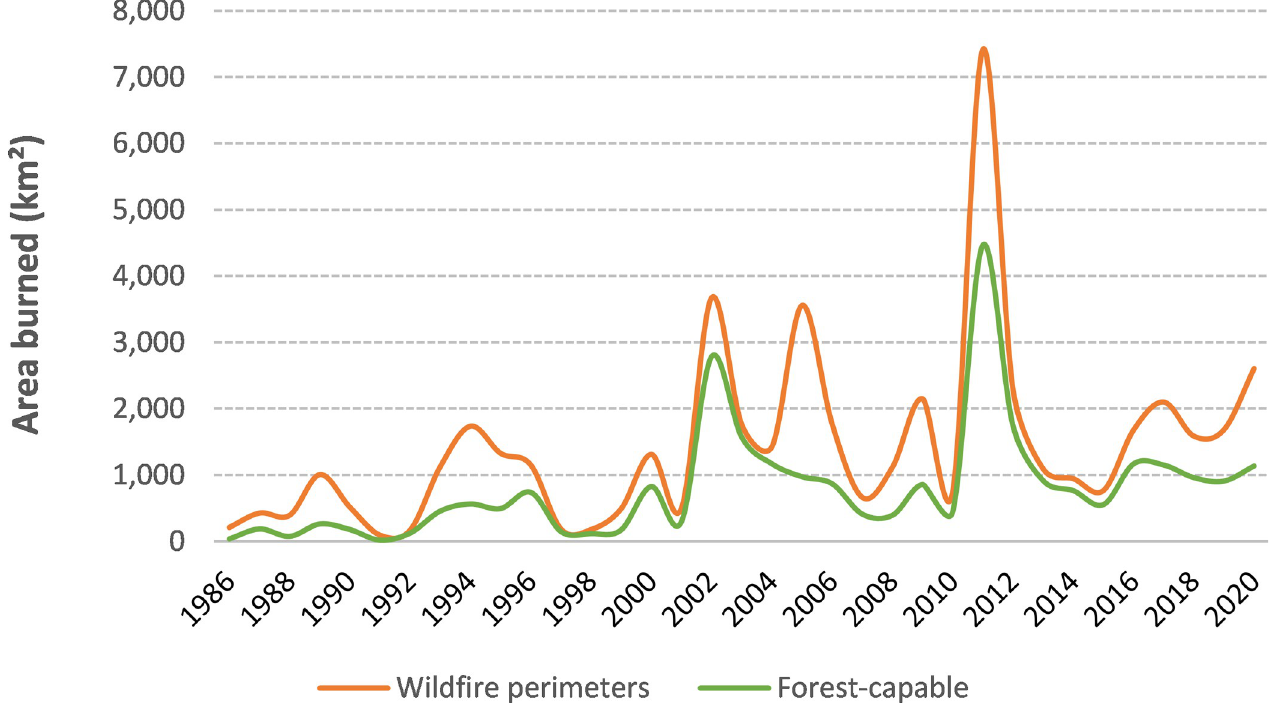
Fig 10. Area burned by large ( � 400 ha) wildfires on our study area between 1986 and 2020. The orange line shows total area burned within wildfire perimeters, whereas the green line shows the area within those wildfire perimeters that burned in forest-capable lands.